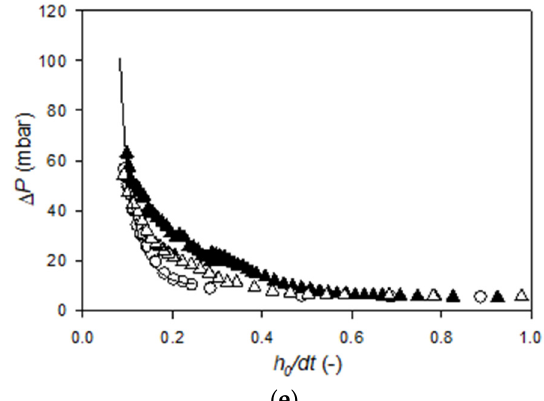
Figure A2. Measured FDG pressure drop vs relative distance profiles for fouling experiments with high surface charge PS–PAA microparticles with ( a – c ) and without ( d , e ) calcium ions.